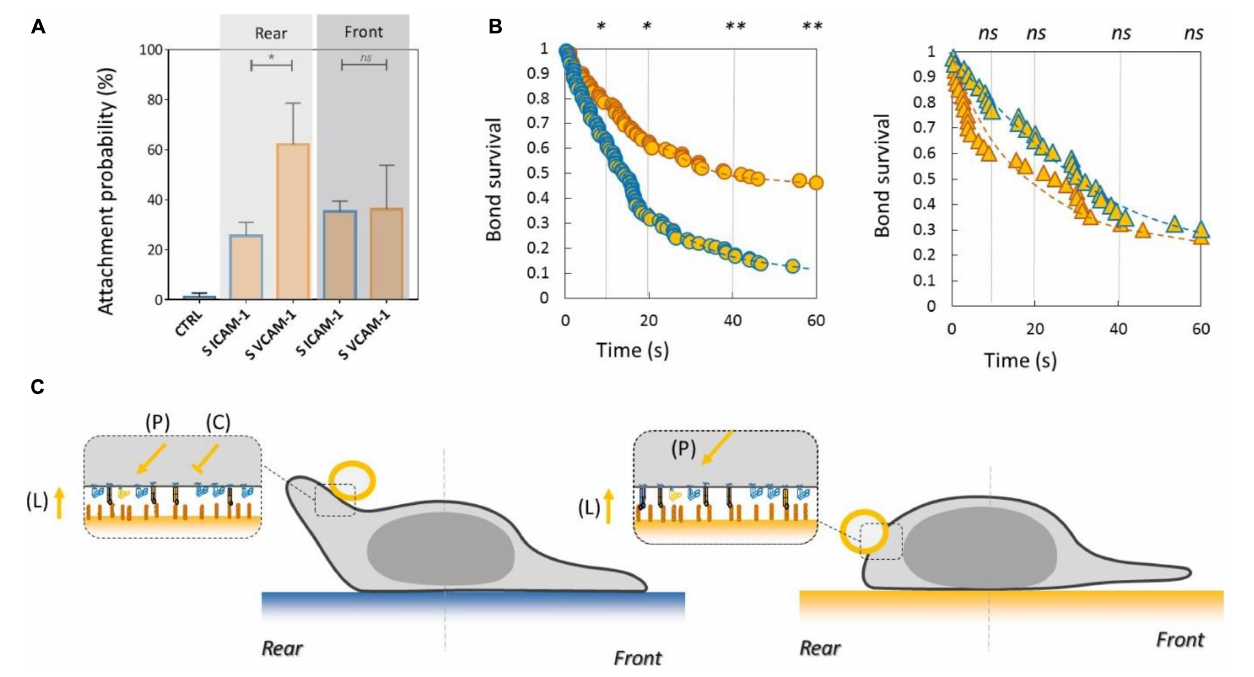
FIGURE 6 | Inhibiting crosstalk of LFA-1 toward VLA-4 modulates cell surface adhesiveness at supramolecular scale across the cell. (A) Attachment probability of beads with VCAM-1 at 2400 molecules. µ m − 2 on the rear and front of cells crawling on substrates coated with ICAM-1 (S ICAM) or VCAM-1 (S VCAM) at 1200 molecules. µ m − 2 . CTRL corresponds to beads coated with irrelevant IgG. Number of independent experiments Nexp = 3. Number of events_per_experiment Ne > 40. (B) Bead/cell survival bonds for beads coated by VCAM-1 at 480 molecules. µ m − 2 attached on cell rear (circles) or (on cell front (triangles) with cells crawling on substrates coated with ICAM-1 (marks circled in blue) and on VCAM-1 (marks circled in orange). Number of independent experiments Nexp = 4, number of events_per_experiment Ne > 70. Error bars are standard deviations for independent experiments. * P < 0.05 and ** P < 0.01, with respect to unpaired Student t -test. In B , statistical tests were performed at 10, 20, 40, and 60 s (dashed lines) and results indicated above the graphs. (C) Cartoon of cell with bead and substrates coated with ICAM-1 (top) and VCAM-1 (bottom). Orange arrows and T-lines indicate activation and inhibiting effects on VLA-4, and letters indicate their origin, i.e., the polarization machinery (P), the presentation of ligand by a surface (L), and the crosstalk from LFA-1